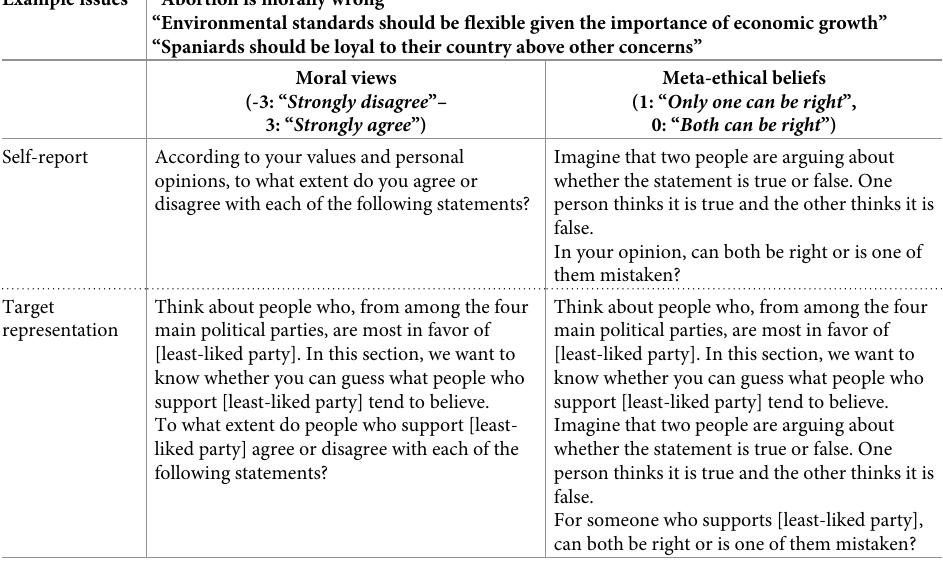
Table 1. A compositional perspective on moral